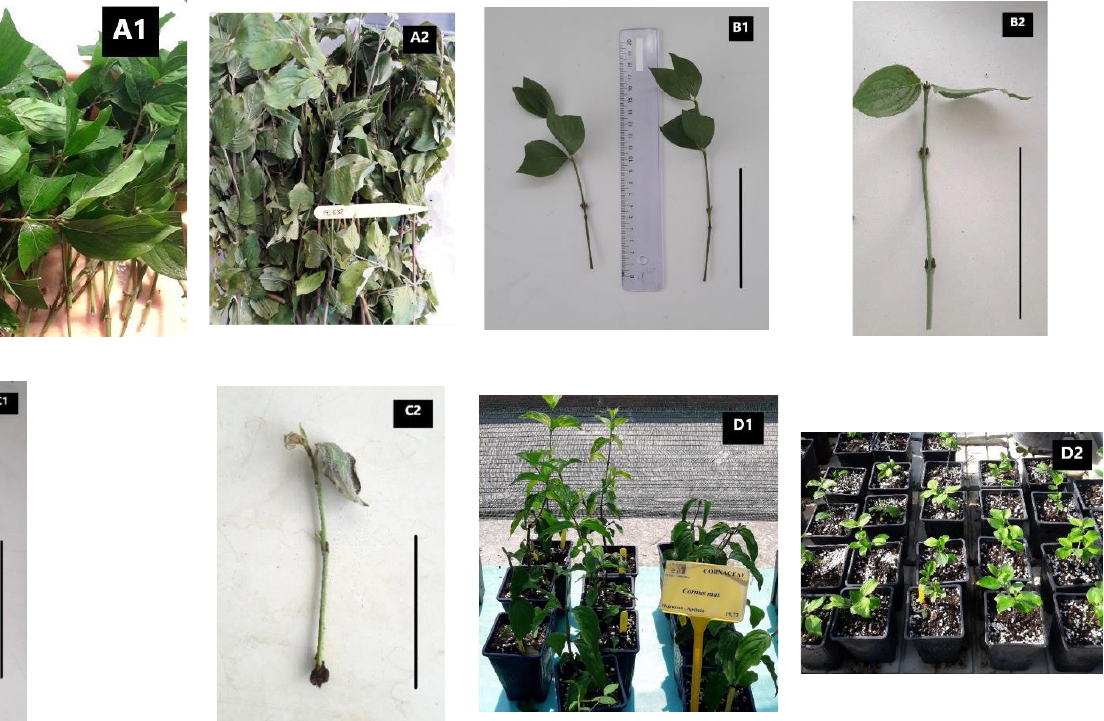
Figure 2. Softwood propagation material collected from representative wild-growing Greek native C. mas genotypes ( A1 : GR-1-BBGK-19,72 and A2 : GR-1-BBGK-19,632) during botanical expeditions. Cutting preparation for genotype GR-1-BBGK-19,502 ( B1 ) and GR-1-BBGK-19,72 ( B2 ). Representa- tive rooted cutting of GR-1-BBGK-19,72 ( C1 ) and cutting that failed to root of GR-1-BBGK-19,72 ( C2 ). Transplanted well-rooted plants under ex situ conservation of genotype GR-1-BBGK-19,72 ( D1 ) and GR-1-BBGK-19,753 ( D2 ). Bars in photos B1, B2, C1, and C2 represent 10 cm.